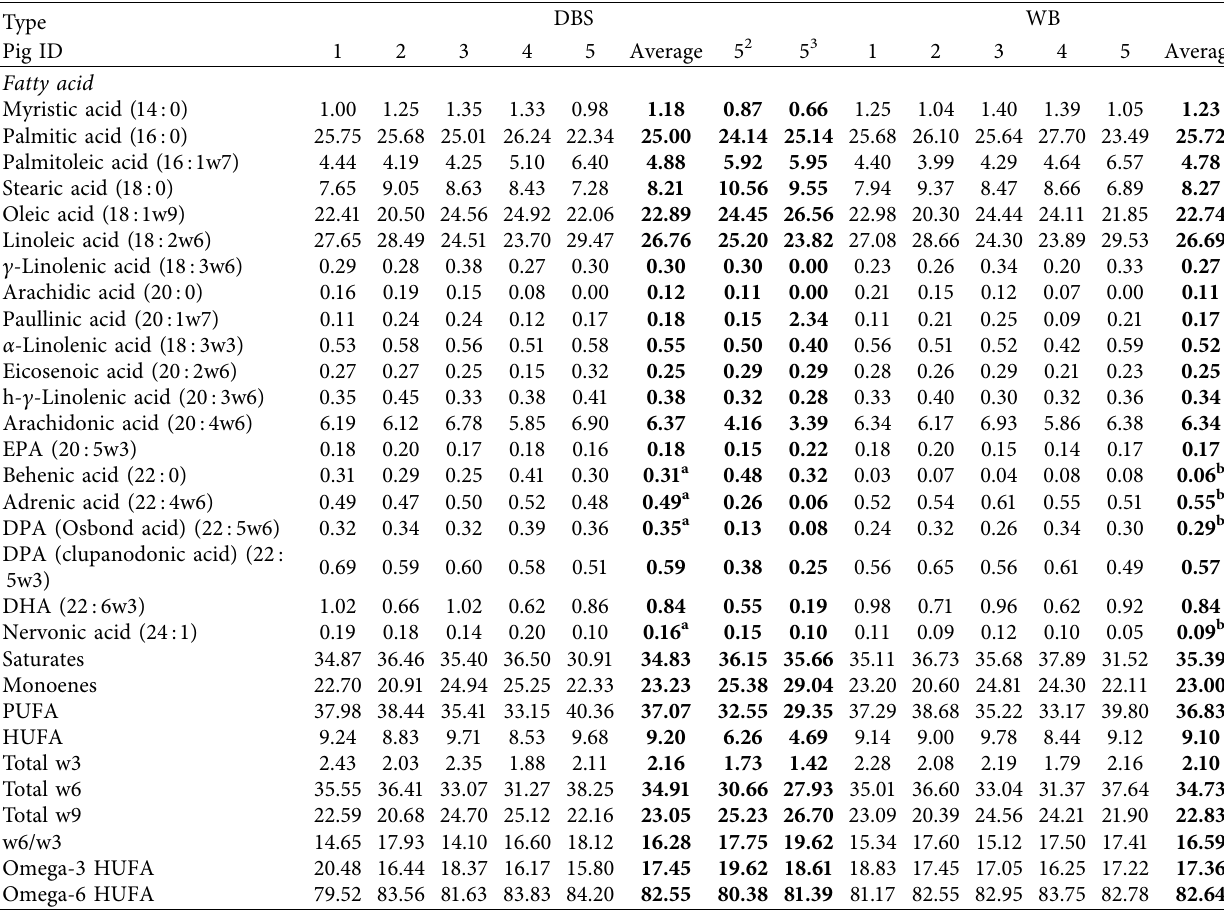
Table 1: Fatty acid (% of total fat) profile of liquid whole blood (WB) ( n � 5) and dried blood spots (DBS) ( n � 5) of 5 pigs with a Mann–Whitney U -test of WB to DBS samples 1